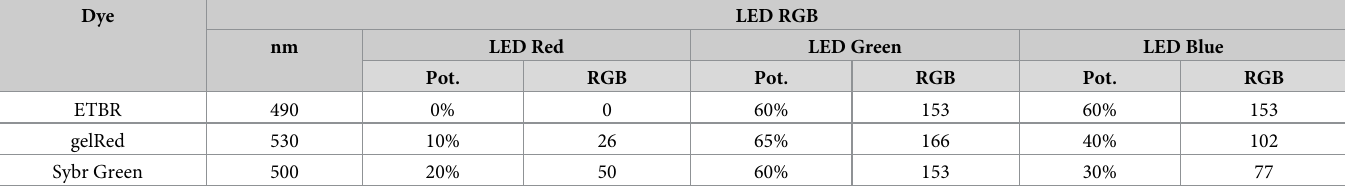
Table 2. LED Power levels (%) for each color and the RGB values used for EtBr, gelRed, and Sybr Green dyes. Dye LED RGB nm LED Red LED Green LED Blue Pot. RGB Pot. RGB Pot. RGB ETBR 490 0% 0 60% 153 60% 153 gelRed 530 10% 26 65% 166 40% 102 Sybr Green 500 20% 50 60% 153 30% 77 Power levels are expressed in percentage of the total power of each color in the LED